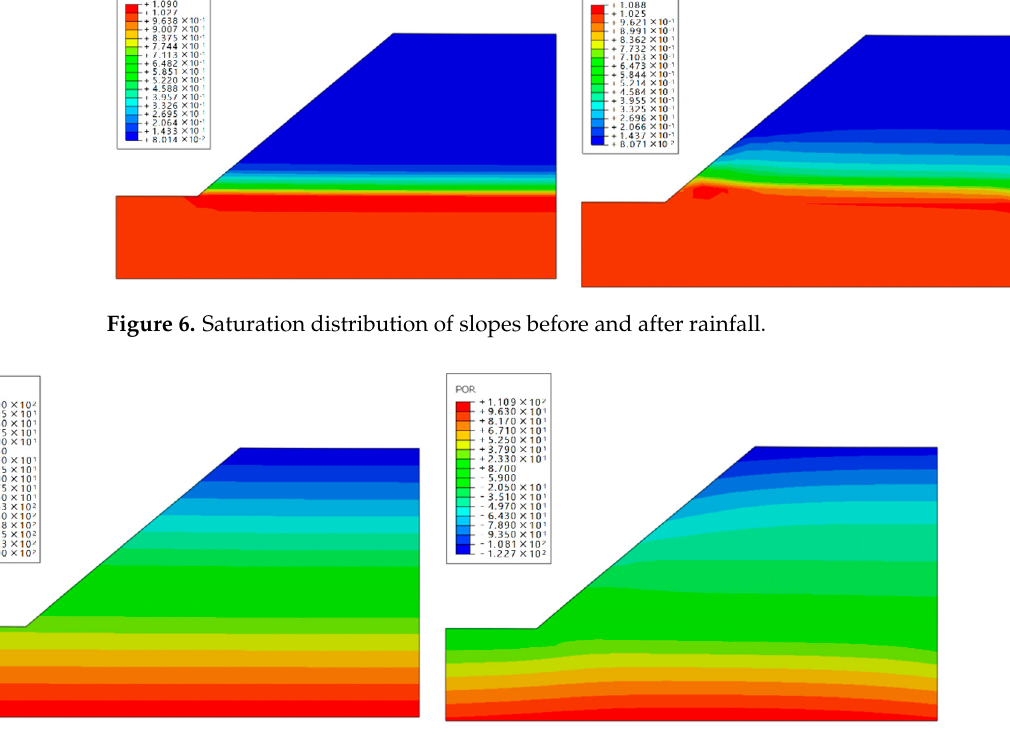
Figure 8. Internal flow velocity of slope at the beginning and end of rainfall. According to the above analysis results: (1) Considering that the pore water pressure distribution after rainfall infiltration differs from the initial state, the suction area below the top of the slope decreases, and the matrix suction also decreases. Comparing the results at different times, it can be found that with the extension of rainfall time, the saturation increases, the pore water pressure increases, and the matrix suction in shallow soil decreases or disappears. After rainfall decreases or stops, saturation decreases gradually with the extension of time, saturation decreases, pore water pressure drops, and matrix suction in the shal- low soil layer increases slowly. (2) The maximum horizontal displacement occurs at the slope toe, and the full settlement occurs in the middle of the soil slope. This is because, after rainfall infiltration, suction decreases. The pore pressure increases, the effective stress decreases, and the unload- ing rebound phenomenon occurs. On the other hand, with rainfall infiltration, soil moisture content and unit weight will increase, leading to heave and stress develop- ment. The slope tends to cause sliding deformation due to rainfall infiltration, so it can be considered that slope stability is reduced. (3) As the rainfall intensity changes according to the law in Figure 2, it first increases from 0 to the maximum value and then gradually decreases to 0. Therefore, at the beginning of rainfall, rainwater infiltrates downward through the slope and slope top. As the rainfall intensity gradually decreases to 0, the overflow phenomenon oc- curs at the slope toe, and the flow velocity is largest at the middle elevation inside the slope. (4) For the slope toe element, the pore water pressure increases, and the effective average stress decreases under the action of rainfall infiltration. The effective stress path reaches the yield surface when it drops to a certain extent. Currently, the stress path moves to the left and down along the yield surface (Mohr–Coulomb strength